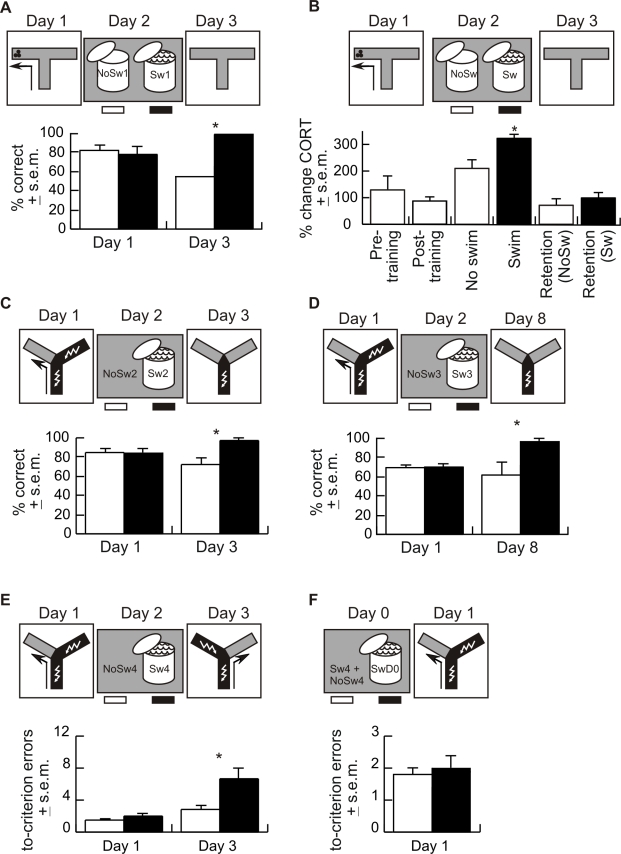
A stressful forced swim enhanced the expression of memory.(A) Experiment 1a—Rats trained on Day 1 in the appetitive left/right discrimination were either forced to swim (group Sw1, black, n = 8) or were put in the same bucket with only 1 cm deep water (group NoSw1, white, n = 9) on Day 2. Average percentage of correct responses in 5 acquisition trials and the percentage of rats that made a correct choice on the first extinction test trial are shown. Retention of memory, measured by the first choice, was better in the Sw1 group (χ2
1 = 6.7; p = 0.01) (* p<0.01). (B) Experiment 1b—To measure circulating corticosterone levels, Experiment 1a was repeated and rats were sacrificed after Halothane anesthesia to collect trunk blood at different phases of the experiment, specifically before (n = 4) or after (n = 5) Day 1 training, after the Day 2 swim (n = 4) and no-swim (n = 5) procedures, and after the retention test on Day 3 in those that underwent swim (n = 7) or no swim (n = 6) on Day 2. A cage control group (n = 4) was removed from their cage and sacrificed. Individual corticosterone levels were normalized to that of the cage controls (229.8±47.5 ng/ml). The effect of experimental phase was significant (F5,28 = 19.8; p = 10−8). Dunnett post hoc tests comparing to pre-training levels only found corticosterone significantly elevated immediately after the swim (* p = 0.0001). (C) Experiment 2—One day after aversive left/right discrimination training in the short training protocol, the Sw2 group (black, n = 8) was forced to swim and the rats in the NoSw2 group (white, n = 10) were only handled. Five retention trials were given on Day 3. The average percent of correct responses on the acquisition and retrieval trials are plotted. The group that was forced to swim (Sw2) made more correct responses on Day 3 (t16 = 3.0, p = 0.008) (* p<0.01). (D) Experiment 2b—Experiment 2a was repeated this time, extending the interval between swim and the retention test to 6 d. The day after aversive left/right discrimination training in the short training protocol, the Sw3 group (black, n = 8) was forced to swim and the rats in the NoSw3 group (white, n = 10) were only handled. Five retention trials were given on Day 8. The average percent of correct responses on the acquisition and retrieval trials are shown. The group that was forced to swim made more correct responses on Day 8 than the group that did not swim (t16 = 2.95; * p = 0.009). (E) Experiment 3a—An aversive left/right discrimination memory was acquired during training on Day 1 using the intensive training protocol. On Day 2 the Sw4 group (black, n = 13) was forced to swim, and the NoSw4 controls were only handled (white, n = 11). Retention was tested on Day 3 by reversal training. The average number of to-criterion errors (4 consecutive correct trials—“4/4”) is plotted. On Day 3, the Sw4 group made more reversal errors (t22 = 2.4; p = 0.02), indicating an enhanced Day 1 memory (* p<0.05). (F) Experiment 3b—A new group of animals was forced to swim 24 h before initial Day 1 training (SwD0, n = 11). Learning was compared with the pooled Day 1 data of the Sw4 and NoSw4 rats (n = 24), which were only handled before training. The groups did not differ (t33 = 0.5; p = 0.6).